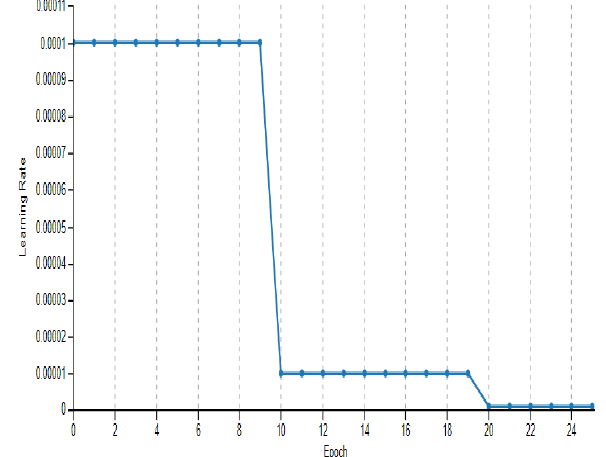
Figure 4. Performance Analysis of Learning Rate during Training